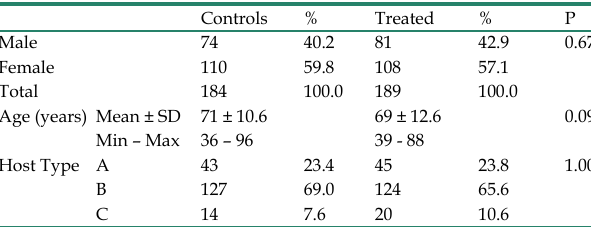
Table 1. Patient demographics and pre-operative data. Host type is defined according to McPherson’s classification.